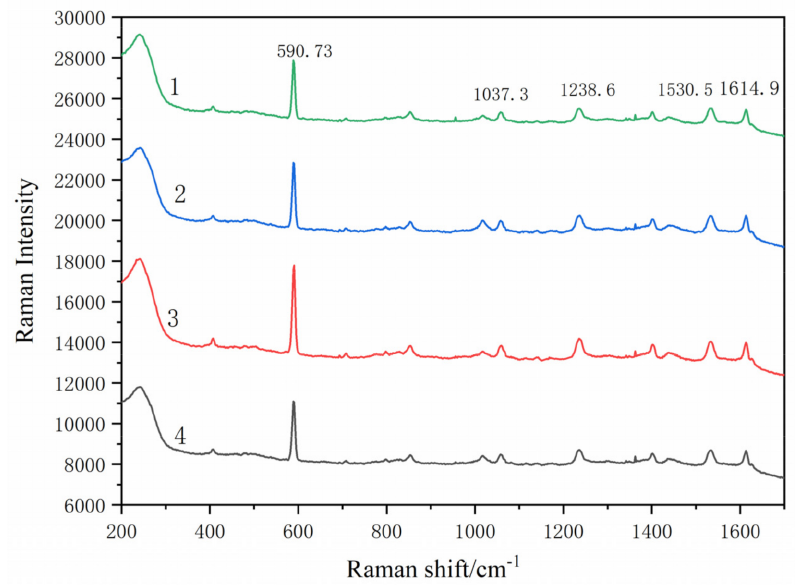
Figure 7. SERS spectra of different mixing volume ratios of Fe 3 O 4 @PDA@Ag@GO substrate and phenanthrene solution (1) 2:1;(2) 1:1; (3) 1:2; (4)